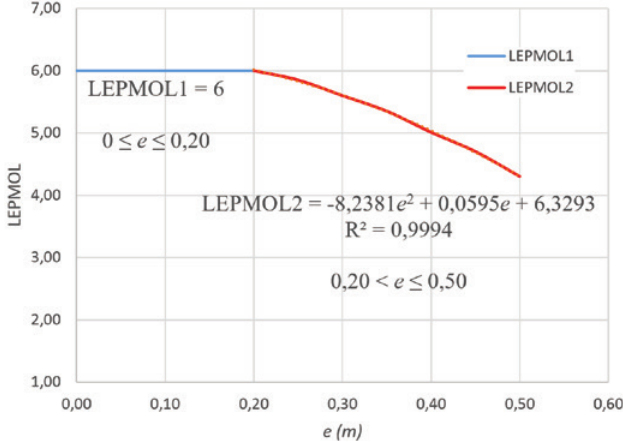
Figura 13 Curva de LEPMOL em função da excentricidade da